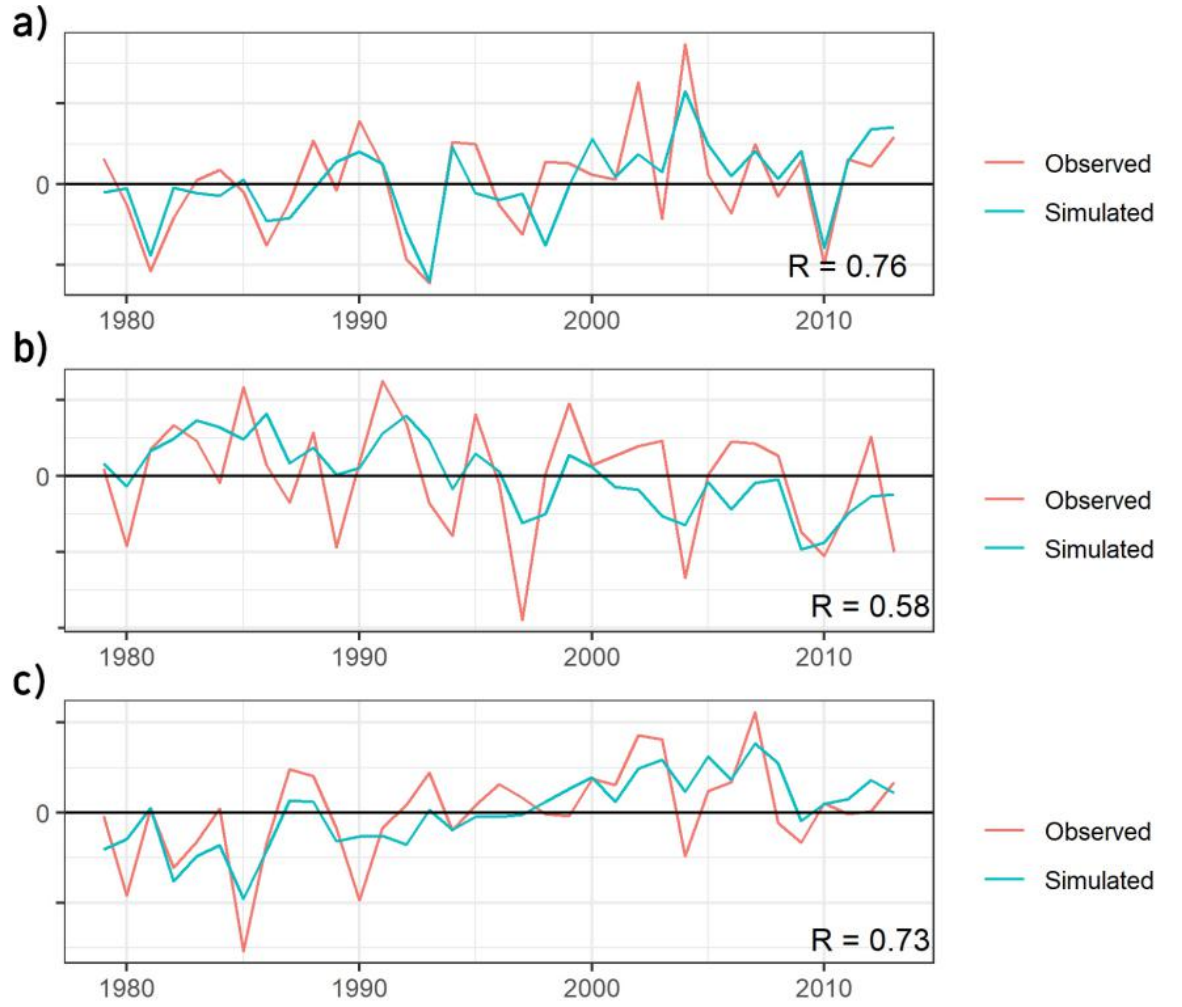
Figure 6. Observed and predicted time series for the first ( a ), second ( b ) and third ( c ) leading modes.